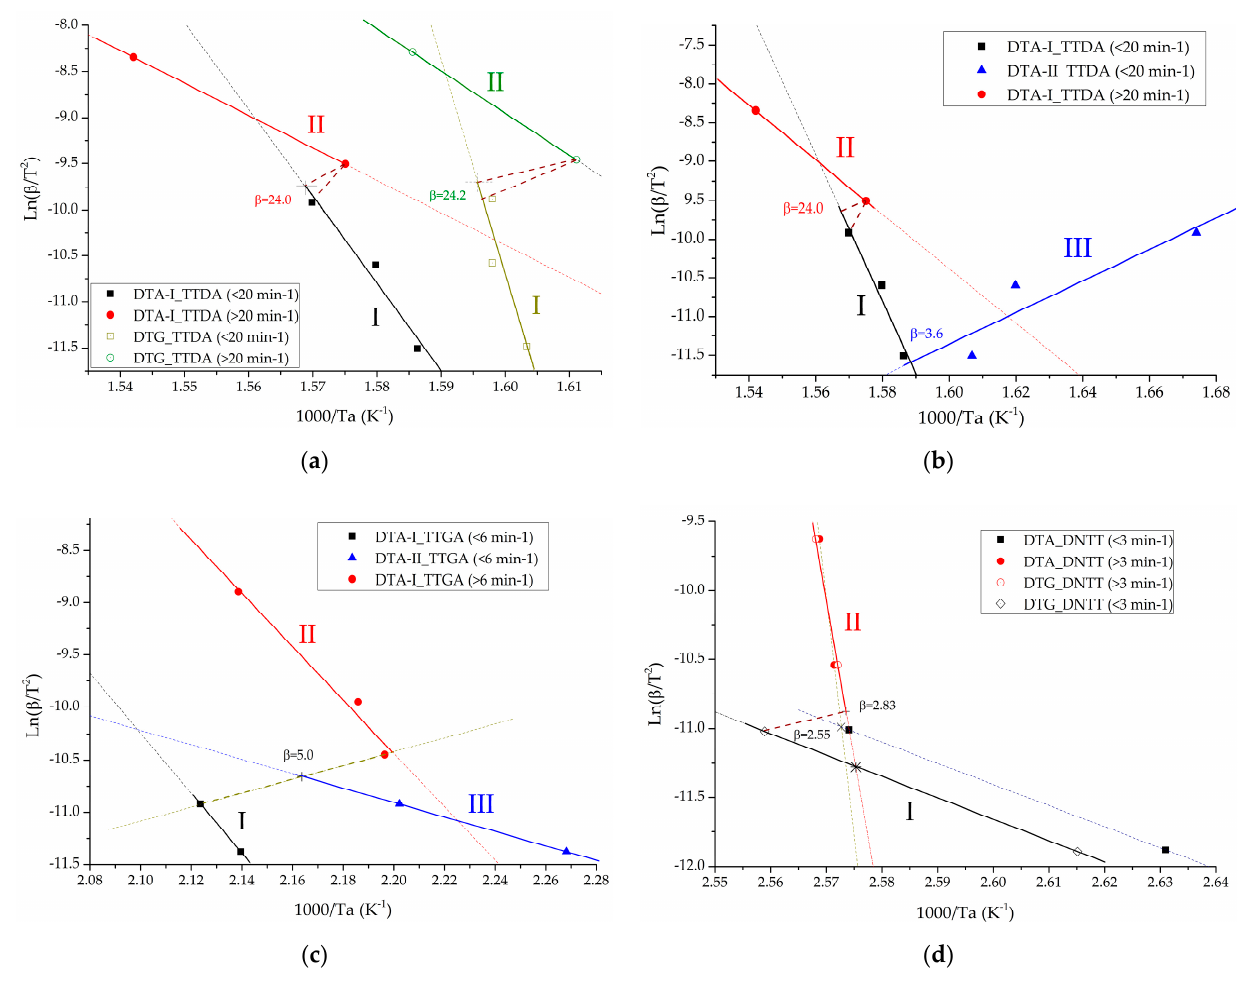
Figure 13. Points of change in the mechanism of chemical reactions in the studied compounds for: TTDA ( a , b ); TTGA ( c ) and DNTT ( d ). DTA-I-parameters of the process of intensive decomposition (maximum exothermic effect) carried out by the method of differential thermal analysis; DTG-I- parameters of the intensive decomposition process (maximum exothermic effect) carried out by thermogravimetric analysis; DTA-II-parameters of the slow decomposition process (previous exother- mic effect) carried out by differential thermal analysis; DTG-II-parameters of the slow decomposition process (previous exothermic effect) carried out by thermogravimetric